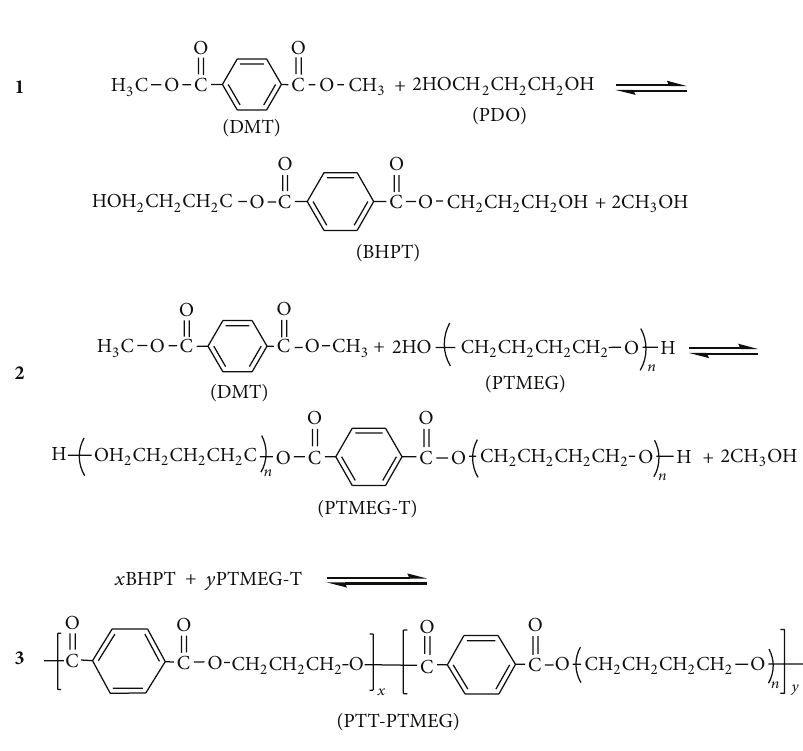
Scheme 1: Synthetic reactions of